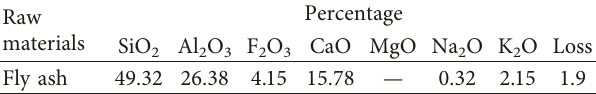
Table 1: Chemical compositions of raw